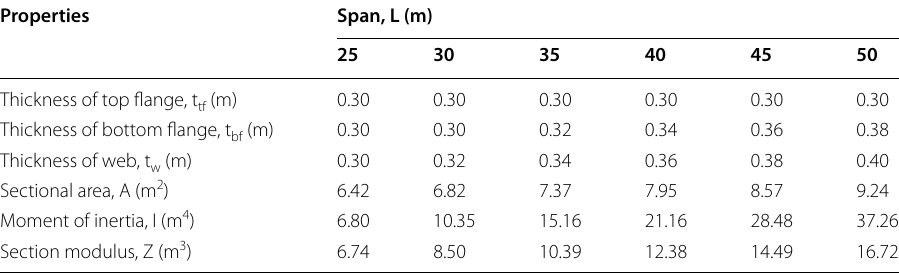
Table 1 Geometric properties of single cell box-girder bridge